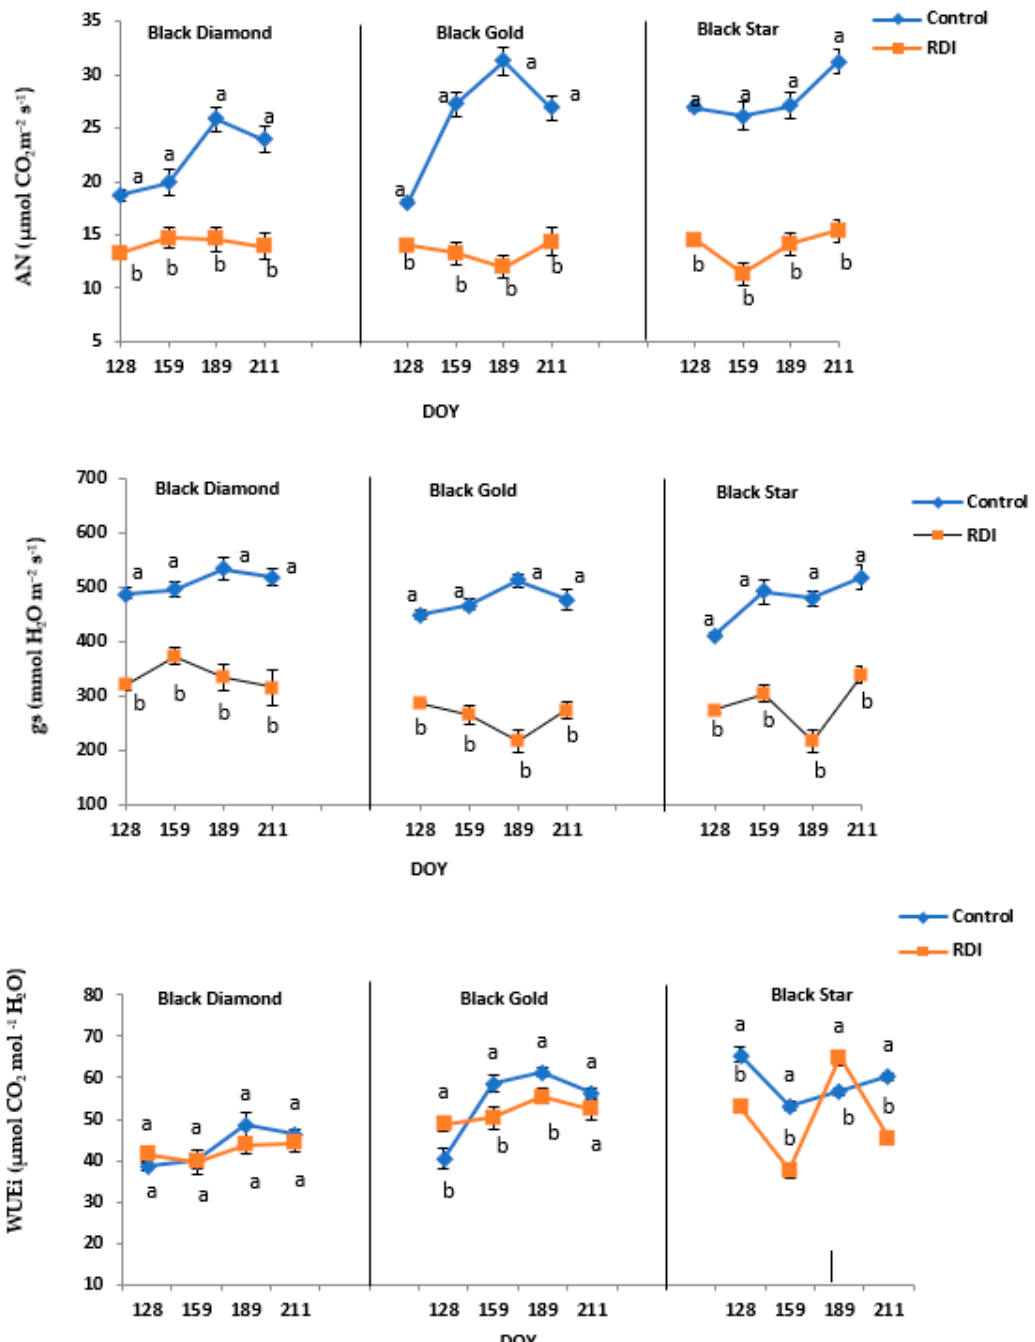
Figure 4. Modification of net assimilation photosynthetic rate (AN) ( µ mol CO 2 m − 2 s − 1 ), stomatal conductance rate (gs) (mmol H 2 O m − 2 s − 1 ), and Intrinsic water use efficiency (WUEi = AN/gs) ( μ mol CO 2 mol − 1 H 2 O) of the three plum cultivars (BD, BG, and BS) subjected (RDI) or not (CI) to regulate deficit irrigation in a sunny day. Values are the means of twelve samples ( n = 12) ± standard devia- tion. The letters a and b indicate significant differences ( p ≤ 0.05), between the two irrigation treat- ments, within the same date.